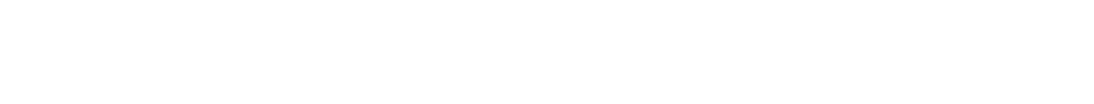
FIGURE 3 | Event-related potential in microvolts across the scalp at 238ms post onset of the critical word, approximately at the peak of the difference. Blue hues indicate negative potentials, red hues positive potentials.The two conditions shown areTrue-Mismatch (A) andTrue-Match (B) .